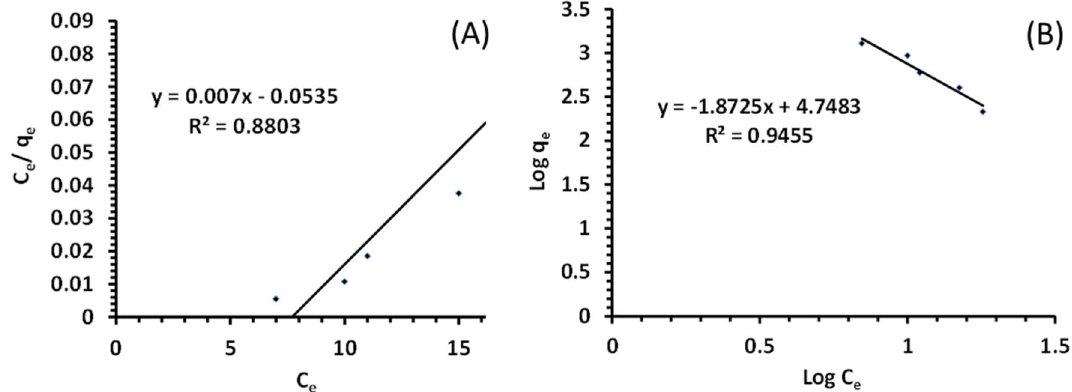
Figure 9. Adsorption isotherm models ( A ) Plot of qe and Ce for linear Langmuir ( B ) Plot of log qe and log Ce for linear